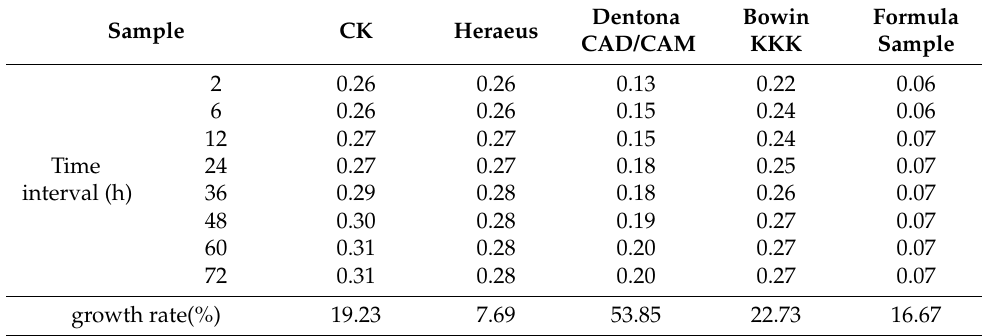
Table 2. Linear expansion coefficient within 72 h